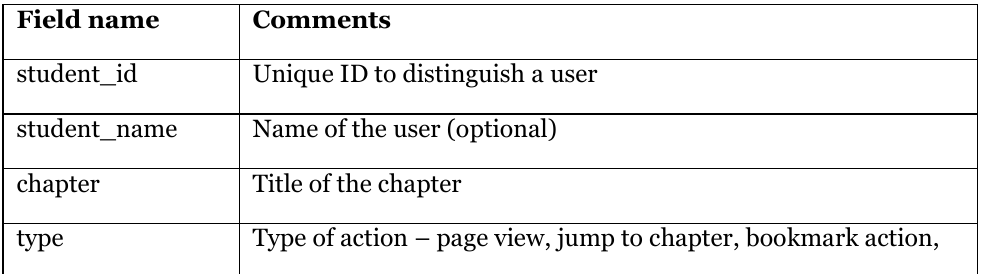
Data Recorded for Each User